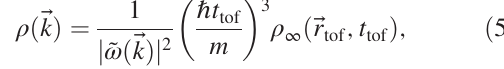
FIG. 1. Observation of the superfluid-to-Mott transition in momentum space with 4 He (cid:3) atoms. Far-field three-dimensional atom distributions, along with the corresponding two-dimensional projections in the ( k revealed by the He* detector. (a) Superfluid regime at U=J ¼ 5 , (b) Mott regime U=J ¼ 100 , (c) superfluid regime U=J ¼ 5 restored when sweeping back from U=J ¼ 100 to U=J ¼ 5 . With this set of data, the visibility of the interference pattern [23] goes from V ¼ 0 . 96 in (a) to V ¼ 0 . 92 in (c). This observation demonstrates that the loading ramps are adiabatic with a good